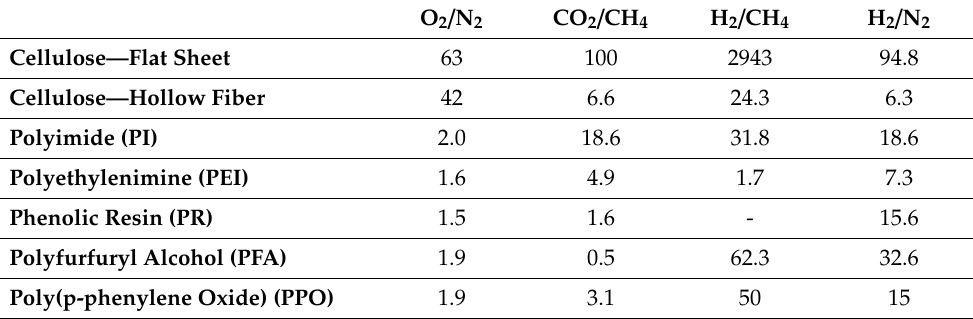
Table 5. Higher reported Robeson Index values for the O 2 / N 2 , CO 2 / CH 4 , H 2 / CH 4 and H 2 / N 2 separations for di ff erent CMSM polymeric precursors (Please find the other results in the Table S1 in the Supporting Information).